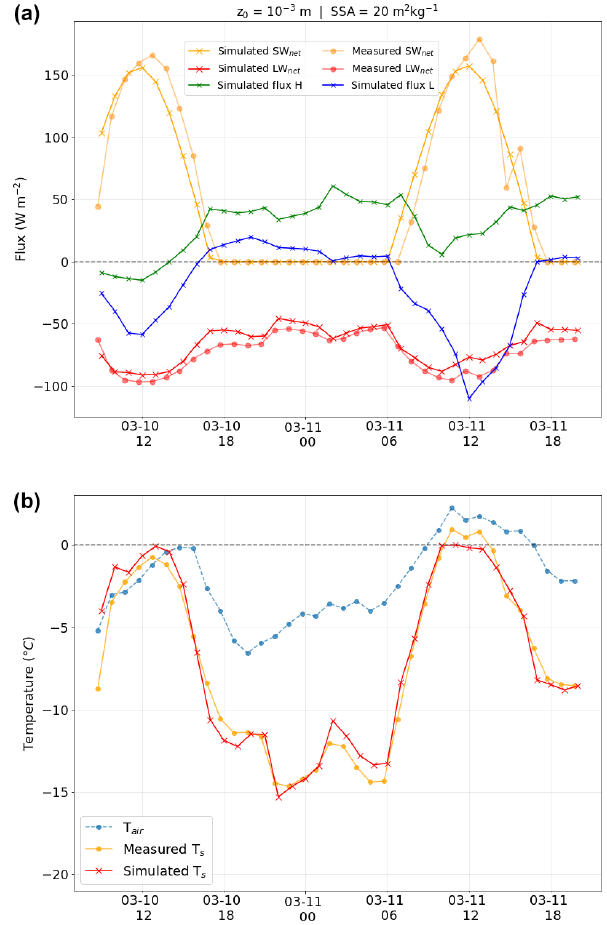
Figure 6. Simulation of the surface fluxes (a) and snow surface tem- perature (b) at the FluxAlp station for a ≈ 36h long time series starting 10 March 2016. The radiative fluxes are compared to in situ measurements. All times are in